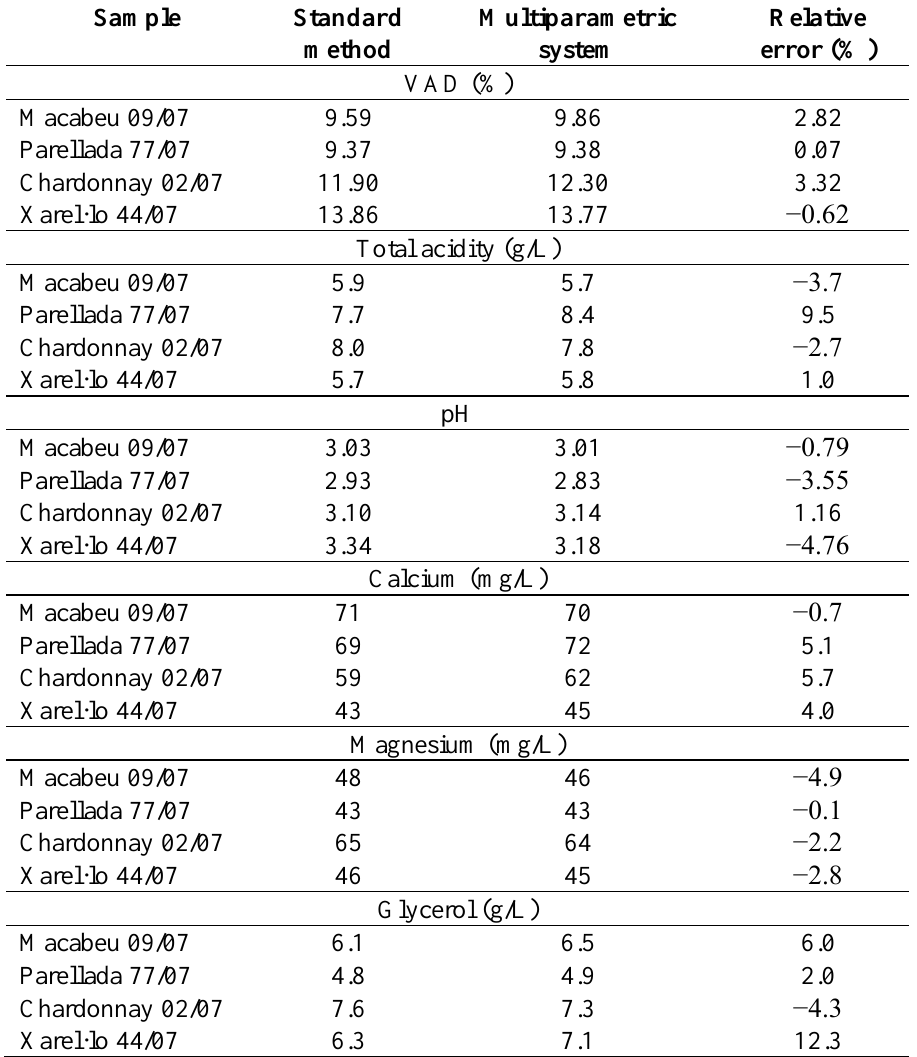
Table 4. Quantification with PLS technique of some chemical parameters of white wine samples with the system. Standard method’s data were provided by INCAVI and relative error refers to these